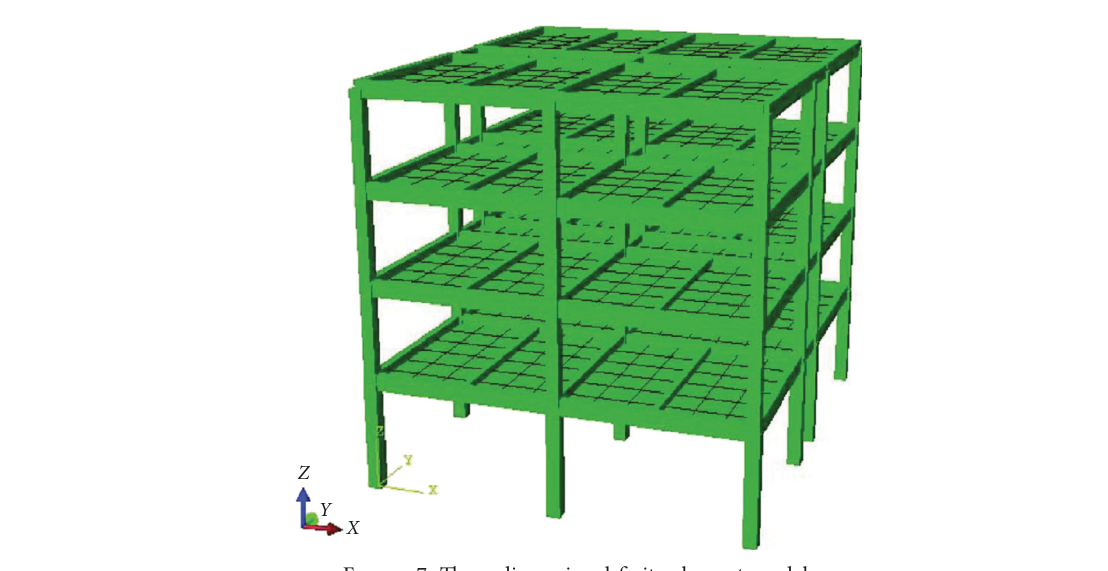
Figure 7: Three-dimensional finite element model.